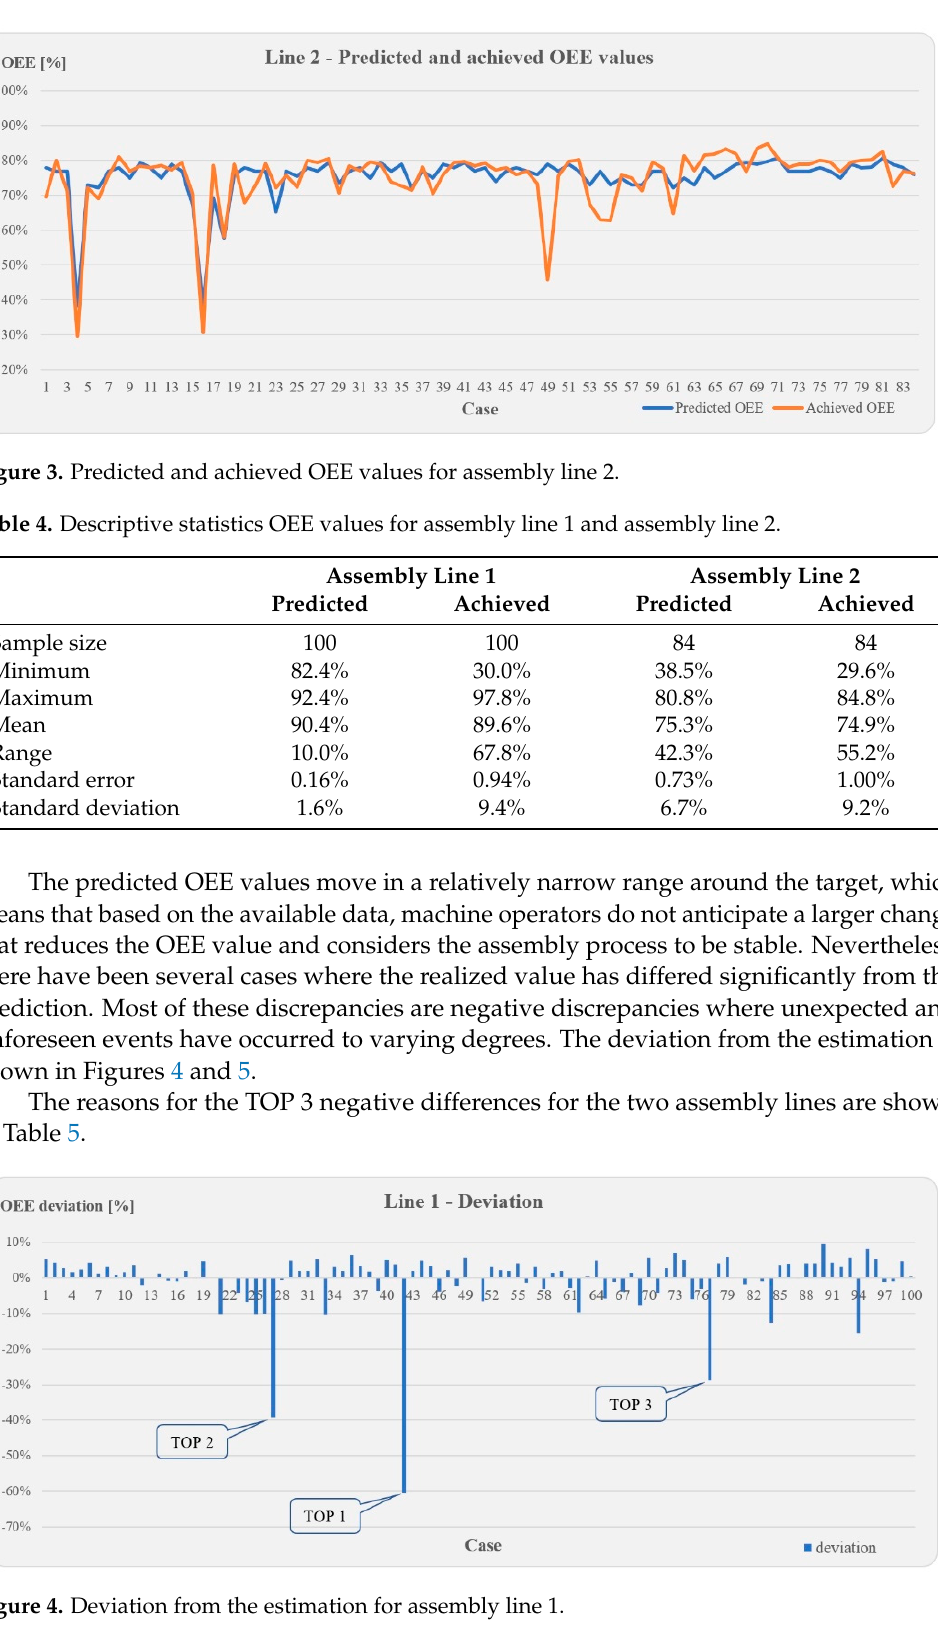
Figure 2. Predicted and achieved OEE values for assembly line 1.